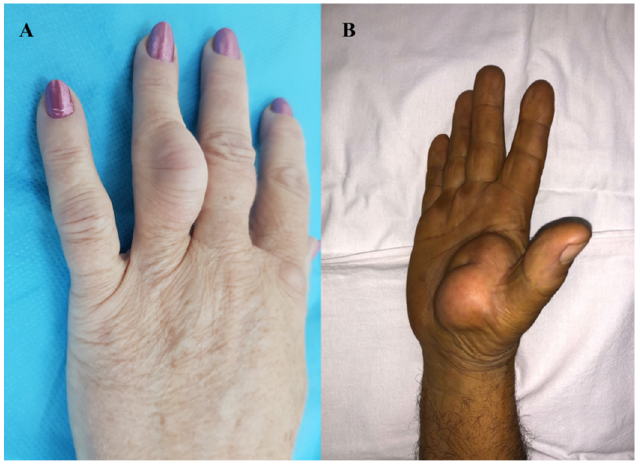
Figure 1. Clinical aspect of the lipoma: ( A ) ring finger localization, ( B ) thenar eminence localiza- tion.